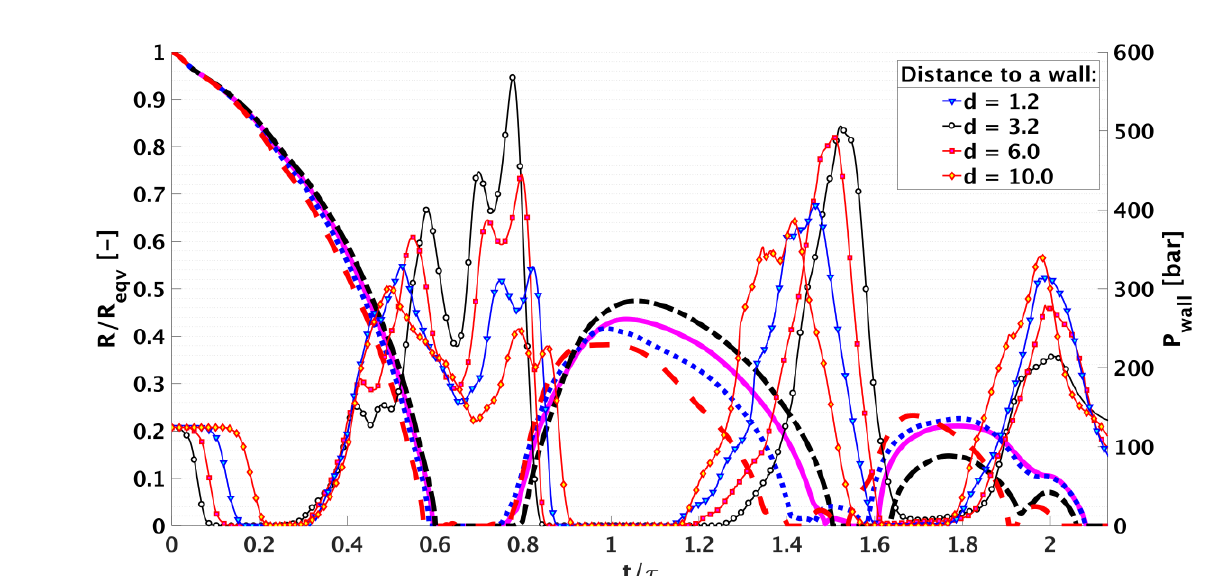
Fig. 9: Setup II: Thick line – equivalent bubble radius evolution; thin line - pressure recorded by the wall transducer; both against dimensionless time scaled with Rayleigh time for equivalent bubble secondary cloud is presented in Figure 8.